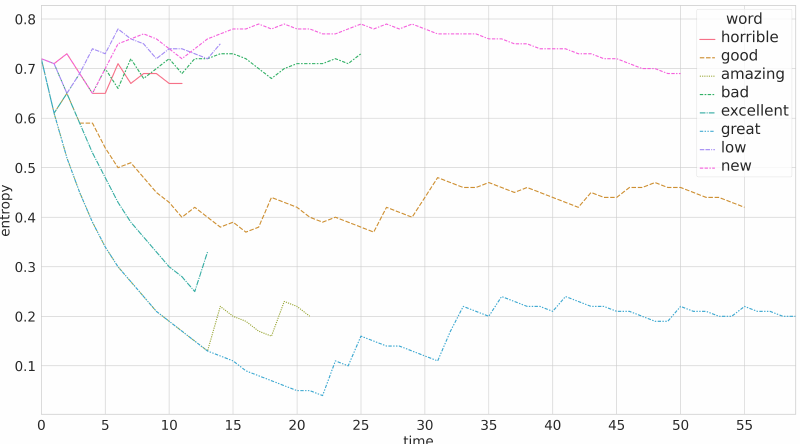
Figure 6. Entropy value over time of the battery-descriptive words.